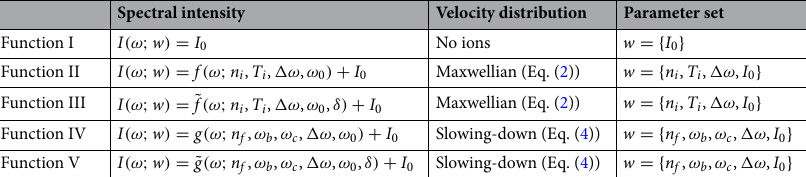
Spectral intensity Velocity distribution Parameter set Function I I (ω ; w ) = I 0 No